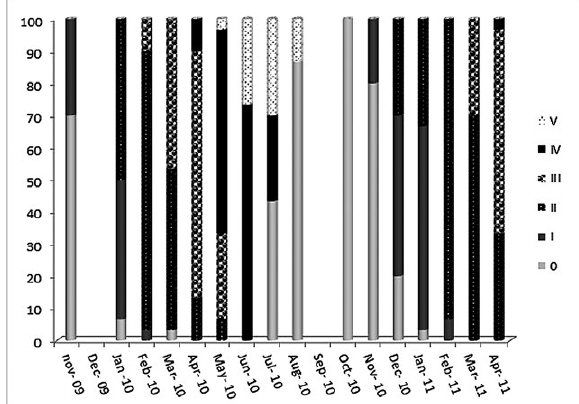
Fig. 4. – Monthly frequency of gonad developmental stages of Acanthocardia tuberculata . 0, resting; I, early active; II, late active; III, ripe; IV, partially spawned, and V, spent.